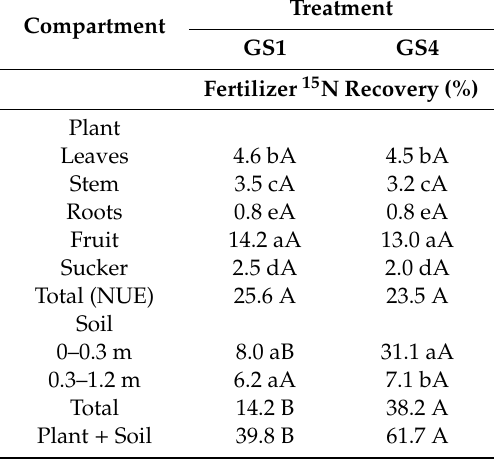
Table 2. Recovery of the fertilizer 15 N in the plant–soil system at banana harvest. 15 N was applied at flowering. GS1 and GS4 refer to the first and the fourth growing seasons, respectively. Fertilizer 15 N recovery in the whole plant represents the N use e ffi ciency (NUE, see Equation (1)). Di ff erent lower-case letters indicate significant di ff erences between plant organs or soil layers within each treatment, and di ff erent capital letters indicate significant di ff erences between treatments for each plant organ or soil layer ( p ≤ 0.05, n =